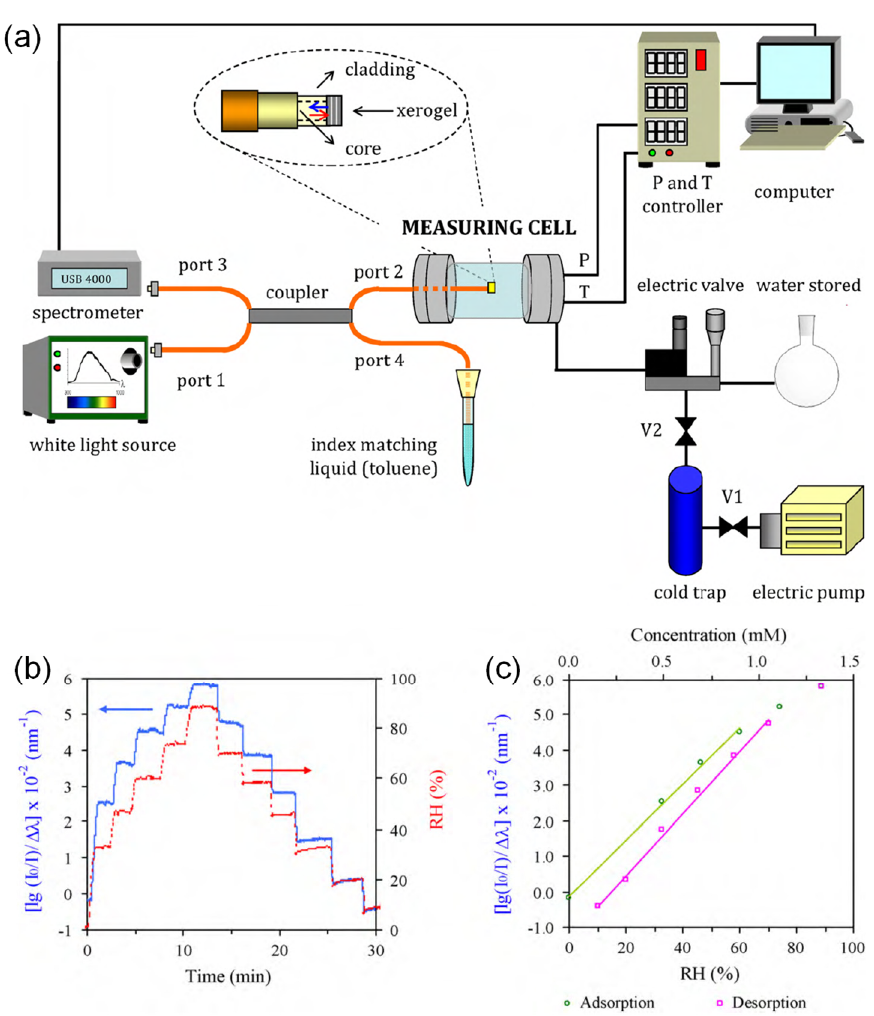
Figure 14. Point sensor. ( a ) Experimental setup. ( b ) Stepped RH cycle response. ( c ) Calibration curves in the range of 630–670 nm. Adapted with permission from ref. [59]. Copyright 2010 Elsevier